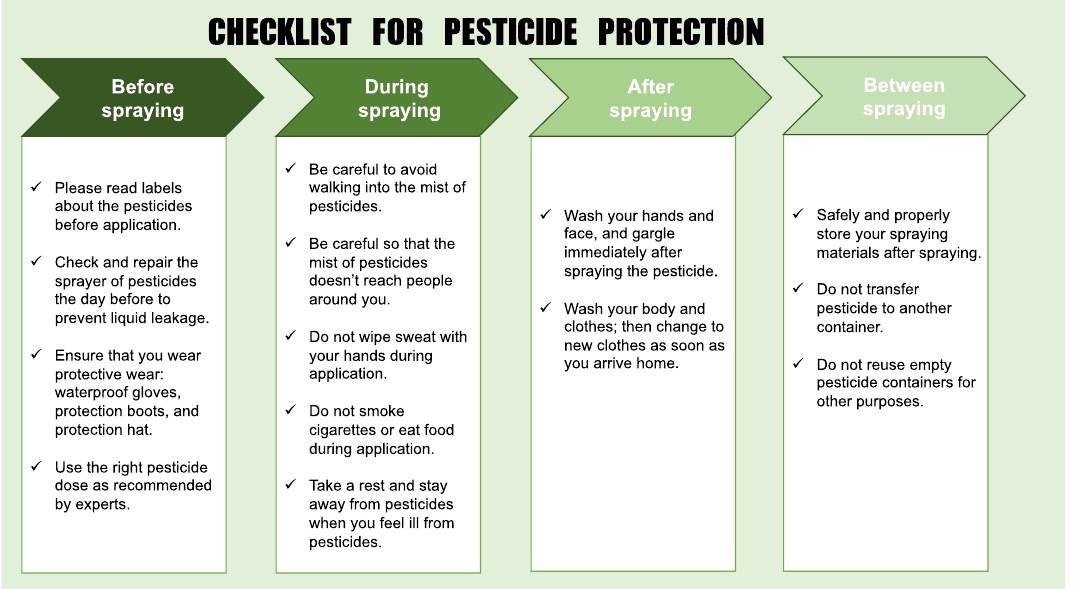
Figure 1. Checklist for pesticide protection.